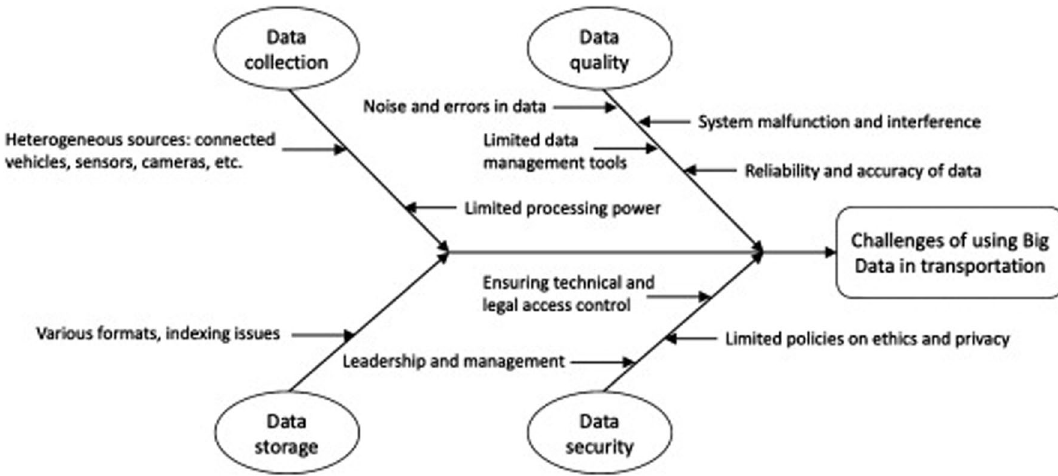
Fig. 1 Challenges of big data in transportation [16] Fig. 2 Architecture from ITS